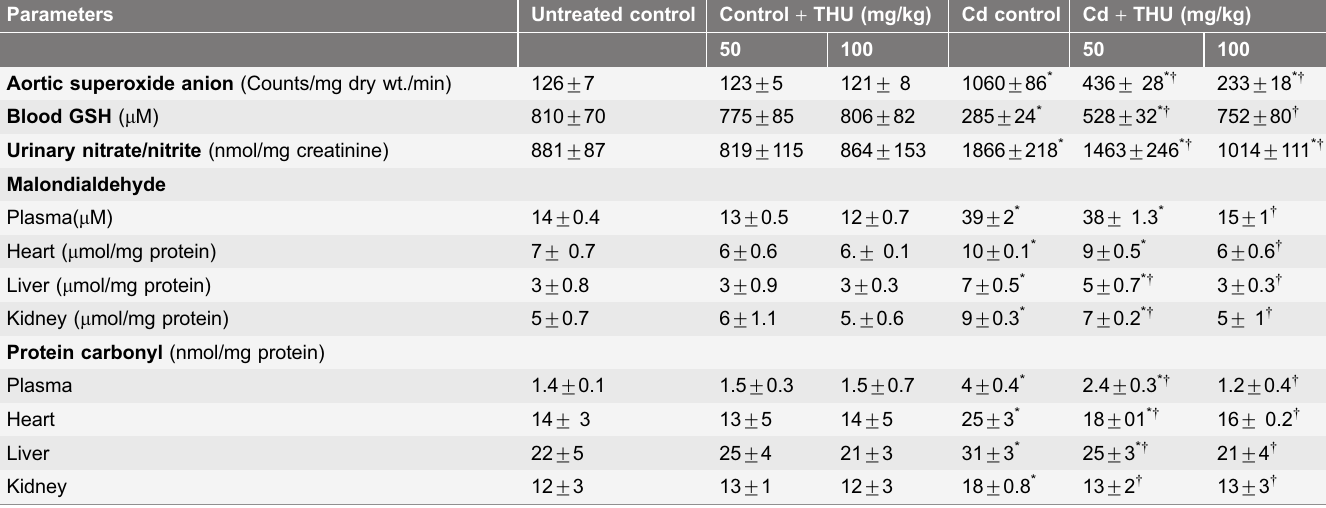
Table 2. Effect of THU on oxidative stress and redox status in all experimental